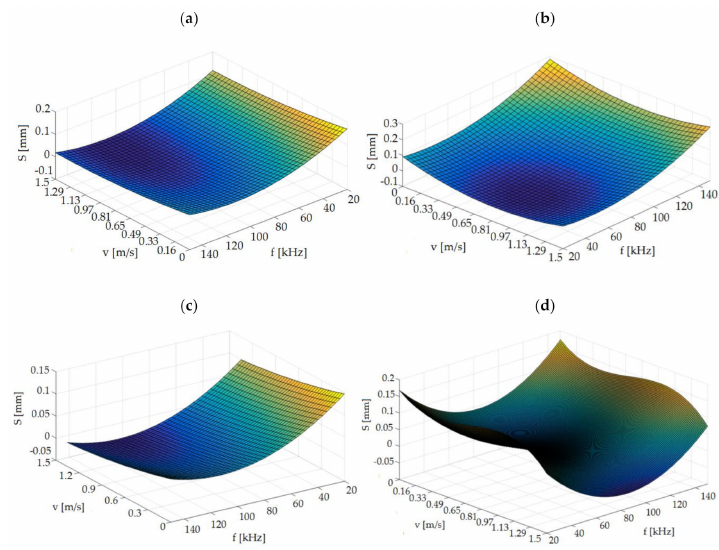
Figure 10. Graph of dependence S = f ( v , f ) for: ( a ) t = 50 µ m, ( b ) t = 60 µ m, ( c ) t = 70 µ m, ( d ) t = 80 µ m.